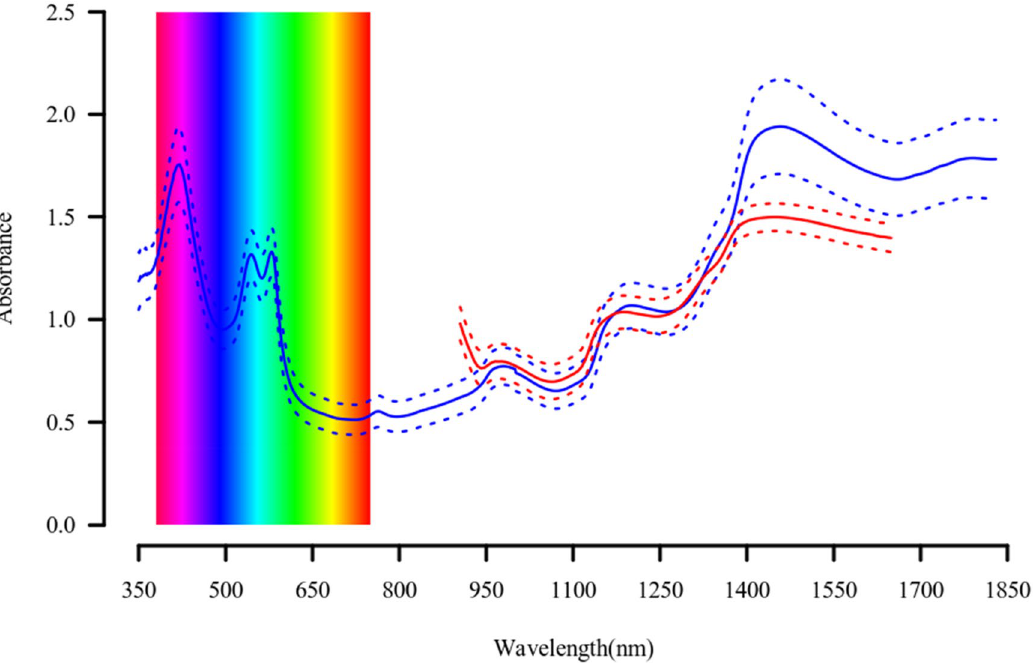
Figure 1. Variability of UV–Vis-NIRS and Micro-NIRS meat spectra. Average (solid line) and standard deviation interval (between dotted lines) of absorbance spectra of 5-6th rib cross-sectional area of longissimus thoracis muscle of Piemontese young bulls obtained using portable UV–Vis-NIRS (blue color) and Micro-NIRS (red color) instruments (the spectrum of each animal was obtained as average of 5 spectra taken in different sites of the muscle sectional area, each one with three